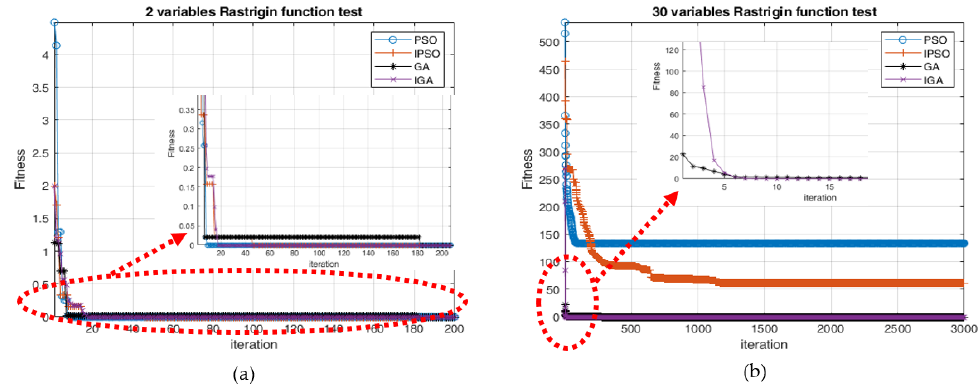
Figure 15. Comparison of the convergence speeds solved by ( a ) 2 variable Rastrigin function and ( b ) 30 variable Rastrigin function .